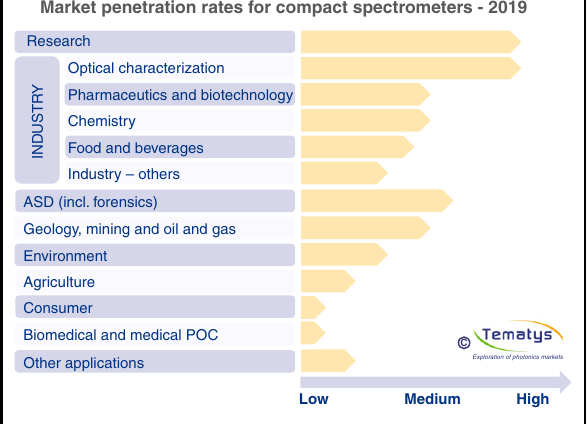
Fig. 1 Market penetration rates for compact spectrometers; yellow and red bars represent the rates in 2019 and 2024, respectively. Reprinted from ref. 9 with permission from